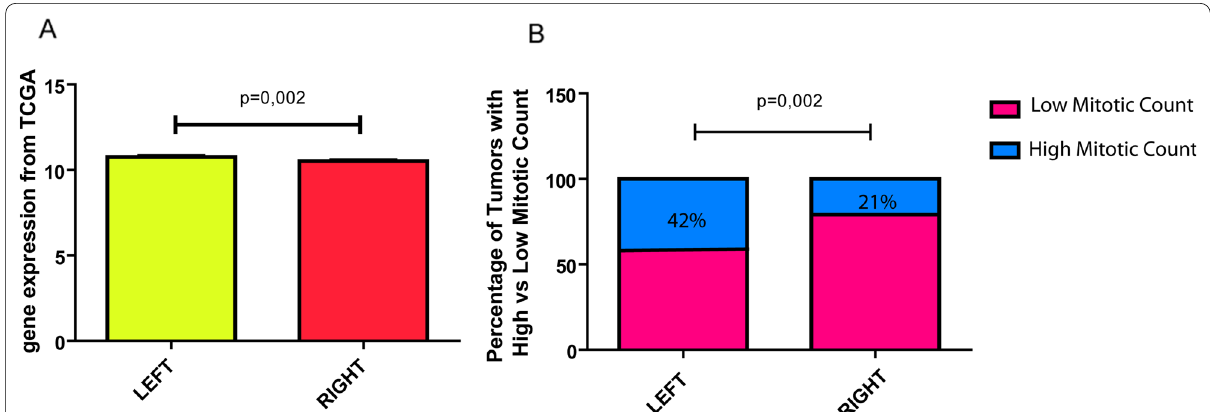
Fig. 7 L–R proliferation rate comparison by KI67 and mitotic index. A Comparison of L–R KI67 expression in 1060 primary breast tumors from TCGA. L expression is subtle but significantly increased (10.76 B Proportion of 95 L–R IDC breast tumors from local female patients with high and low mitotic count (Fisher’s exact Test, p